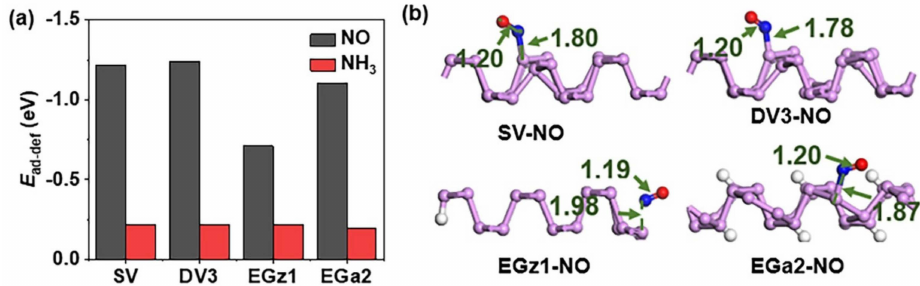
Figure 4. ( a ) Modified interaction energy ( E ad − def , eV) for adsorption of NO and NH 3 on SV, DV3, EGz1 and EGa2. ( b ) The most stable adsorption configurations of NO on SV, DV3, EGz1 and